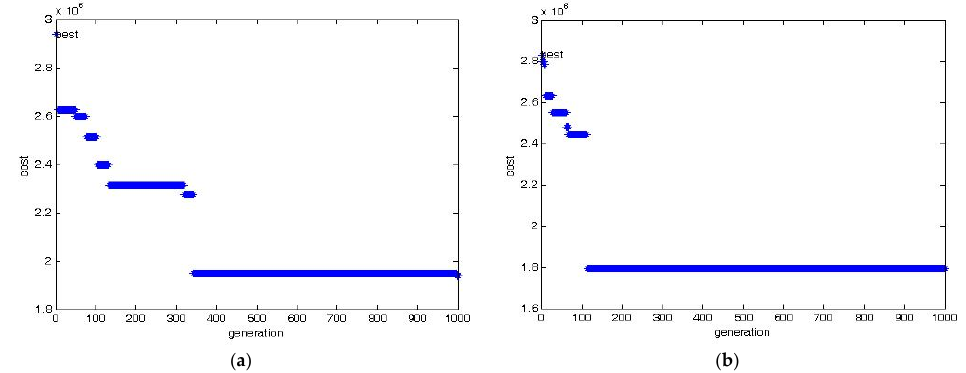
Figure 8. Convergence curve of PSO for the proposed objective function. ( a ) Scenario 1 (3 RSFCLs), ( b ) Scenario 2 (5 RSFCLs).